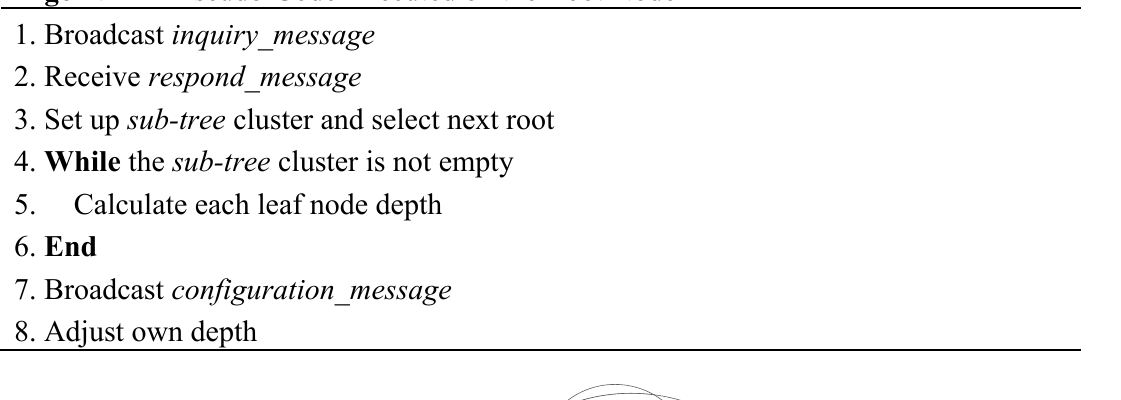
Algorithm 1 Pseudo-Code Executed on the Root Node